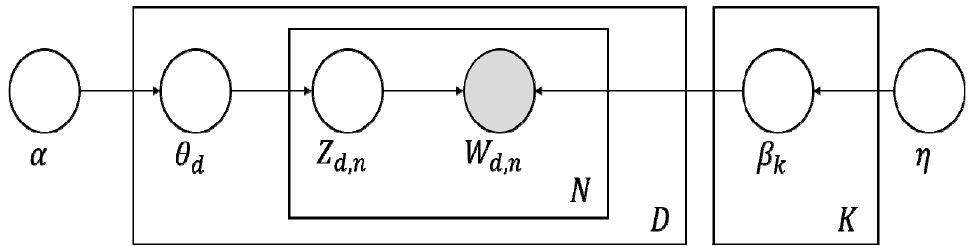
Figure 1. Schematic of the topic modeling algorithm. K : Number of topics; α : Dirichlet prior weight of topic k by document, the parameter which determines the value of θ ; η : Dirichlet prior weight of word w by document, the parameter which determines the value of β ; θ d : The ratio of topics by document; β k : The probability that word w will be generated by topic; Z d , n : The topic of the nth word in document